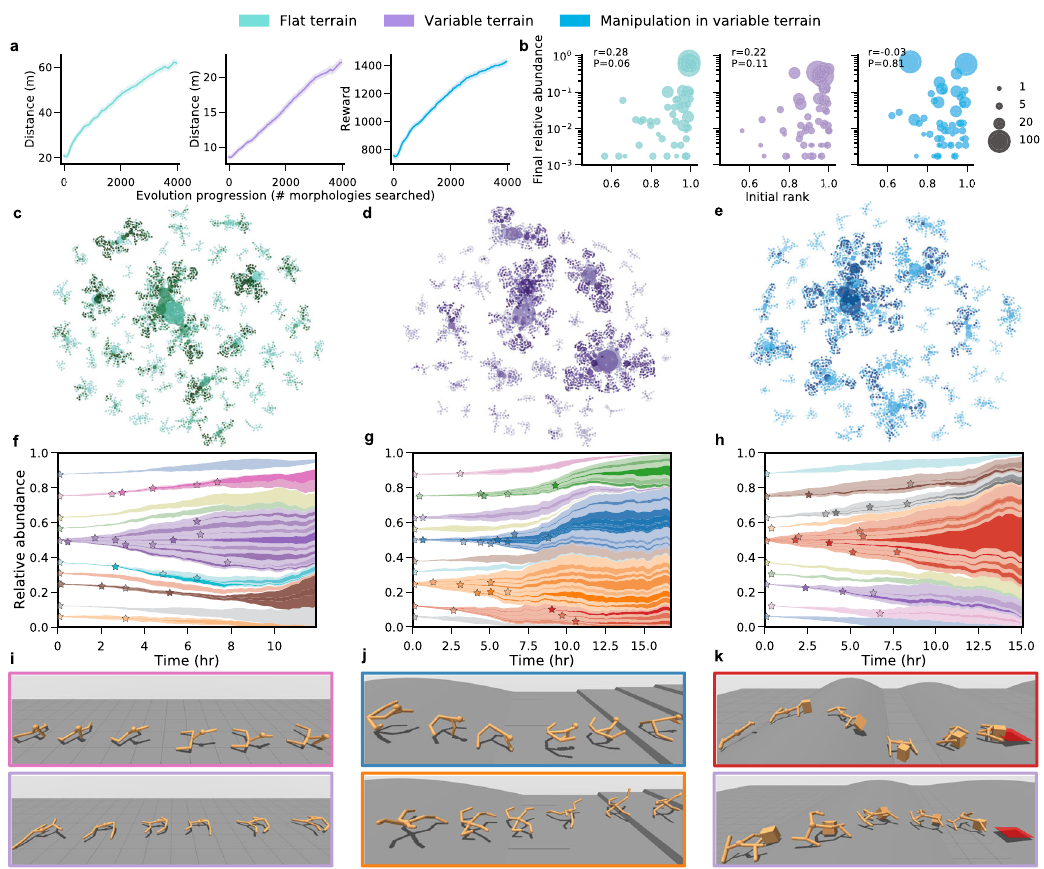
Fig. 2 Evolutionary dynamics in multiple environments. a Mean and 95% bootstrapped con fi dence intervals of the fi tness of the entire population across 3 evolutionary runs. b Each dot represents a lineage that survived to the end of one of 3 evolutionary runs. Dot size re fl ects the total number of bene fi cial mutations (see “ Methods ” ) accrued by the lineage. The founder of a lineage need not have extremely high initial fi tness rank in order for it ’ s lineage to comprise a reasonably high fraction of the fi nal population. It can instead achieve population abundance by accruing many bene fi cial mutations starting from a lower rank (i.e., large dots that are high and to the left). c – e Phylogenetic trees of a single evolutionary run where each dot represents a single UNIMAL, dot size re fl ects number of descendants, and dot opacity re fl ects fi tness, with darker dots indicating higher fi tness. These trees demonstrate that multiple lineages with descendants of high fi tness can originate from founders with lower fi tness (i.e., larger lighter dots). f – h Muller diagrams 44 showing relative population abundance over time (in the same evolutionary run as in ( c – e ) of the top 10 lineages with the highest fi nal population abundance. Each color denotes a different lineage and the opacity denotes its fi tness. Stars denote successful mutations which changed agent topology (i.e., adding/deleting limbs) and resulted in a sub-lineage with more than 20 descendants. The abundance of the rest of the lineages is re fl ected by white space. i – k Time-lapse images of agent policies in each of the three environments with boundary color corresponding to the lineages above. b Shown are the correlation coef fi cients ( r ) and P values obtained from two-tailed Pearson ’ s